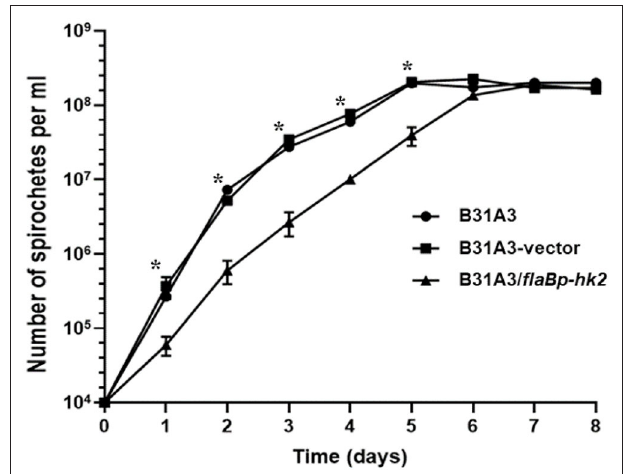
FIGURE 6 | HK2 overexpression resuls in reduced growth rate. Wild-type B. burgdorferi strain B31A3, B31A3 carrying an empty shuttle vector (B31A3-vector), or B31A3 carrying a shuttle vector harboring a hk2 gene driven by a flaB promoter (B31A3 /flaBp-hk2 ) were cultivated in standard BSK-II medium at 37 ◦ C with a initial cell density of 1 × 10 4 spirochetes/ml. Numbers of spirochetes were enumerated under a dark-field microscope. Each data point is the average of data from three independent cultures. * p < 0.01 (paired student